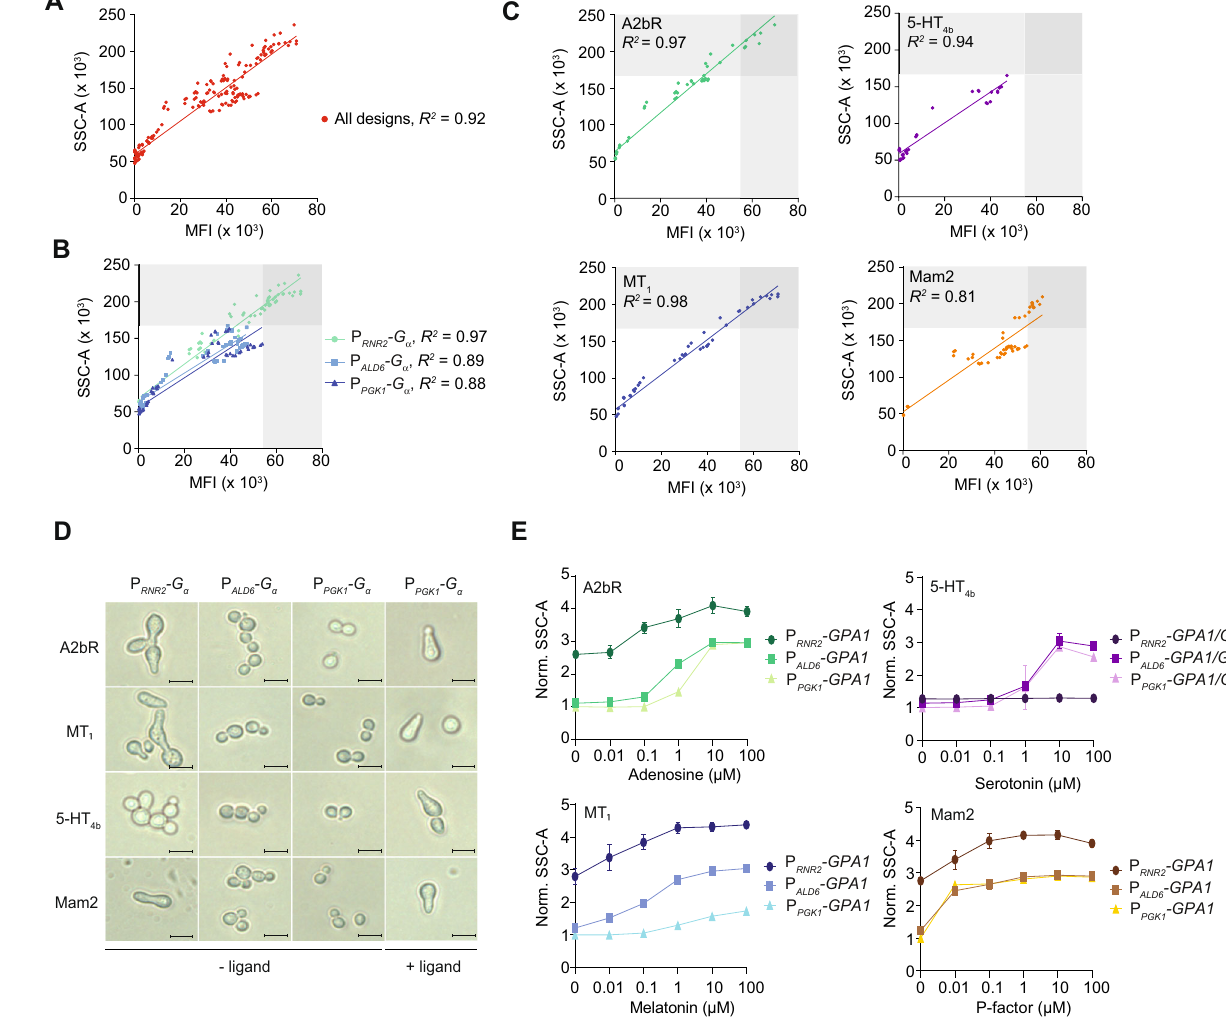
D Representative morphologies in S. cerevisiae strains from panels A – C in the absence ( − ligand) or presence of cognate ligands (+ligand, 100 µ M) for A2bR, MT 1 , and 5-HT 4b , or Mam2 (1 µ M). The experiment was repeated more than three times. Size bars illustrate 10 µ m. E Increasing SSC-A for each strain design in panels A – C across 0 – 100 µ M cognate ligand supplementation as indicated. SSC-A is nor- malized for all strains to the P PGK1 - G α strain without ligand supplementation within each hGPCR design. Data represent means and standard deviations from three biological replicates. Source data are provided as a Source Data fi